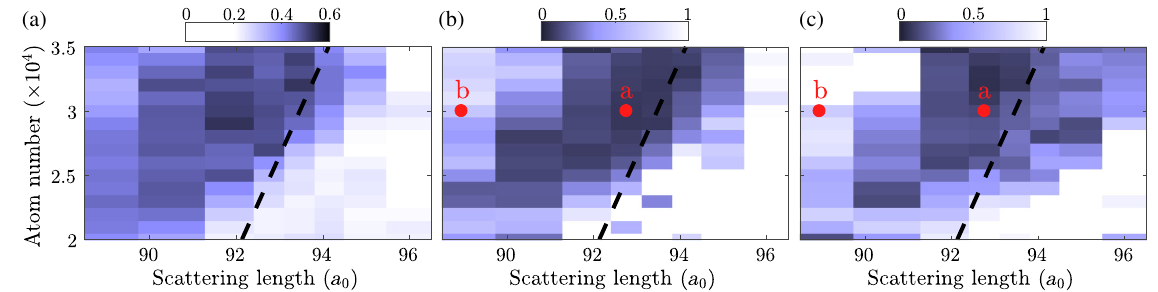
FIG. 5. In situ modulation and phase coherence reveal signatures of the theoretical phase diagram. Spectral weight of the observed in situ modulation (a), nearest-neighbor coherence (b), and next-nearest-neighbor coherence (c). Only in the range where we observe a density modulation in (a) we also see interference patterns emerging in time of flight (b), (c). For a narrow range of the contact interaction strength, we see clear evidence for phase coherence up to the next-nearest neighbor. The red points labeled “ a ” and “ b ” correspond to the exemplary Fourier transforms shown in Figs. 4(a) and (b). The dashed black lines are the same guide to the eye that was shown in Fig.